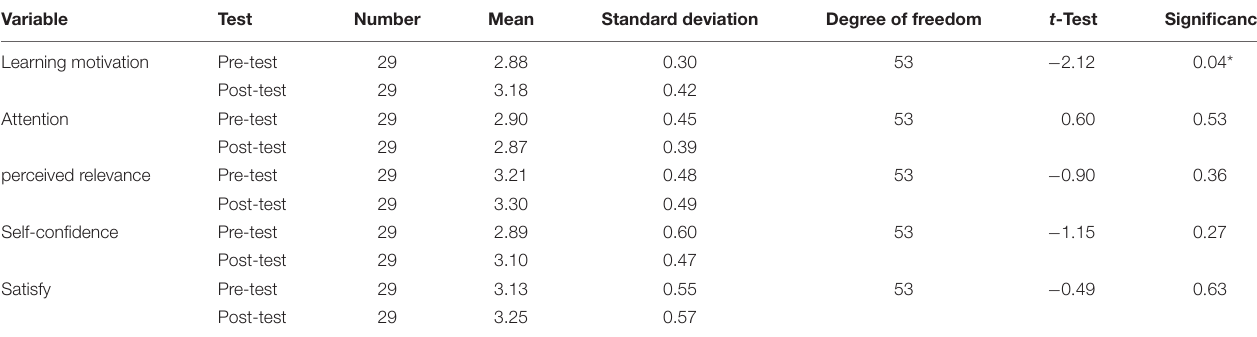
TABLE 10 | The number of repetitions t -test analysis before and after the “ARCS learning motivation scale” of the experimental group. Variable Test Number Mean Standard deviation Degree of